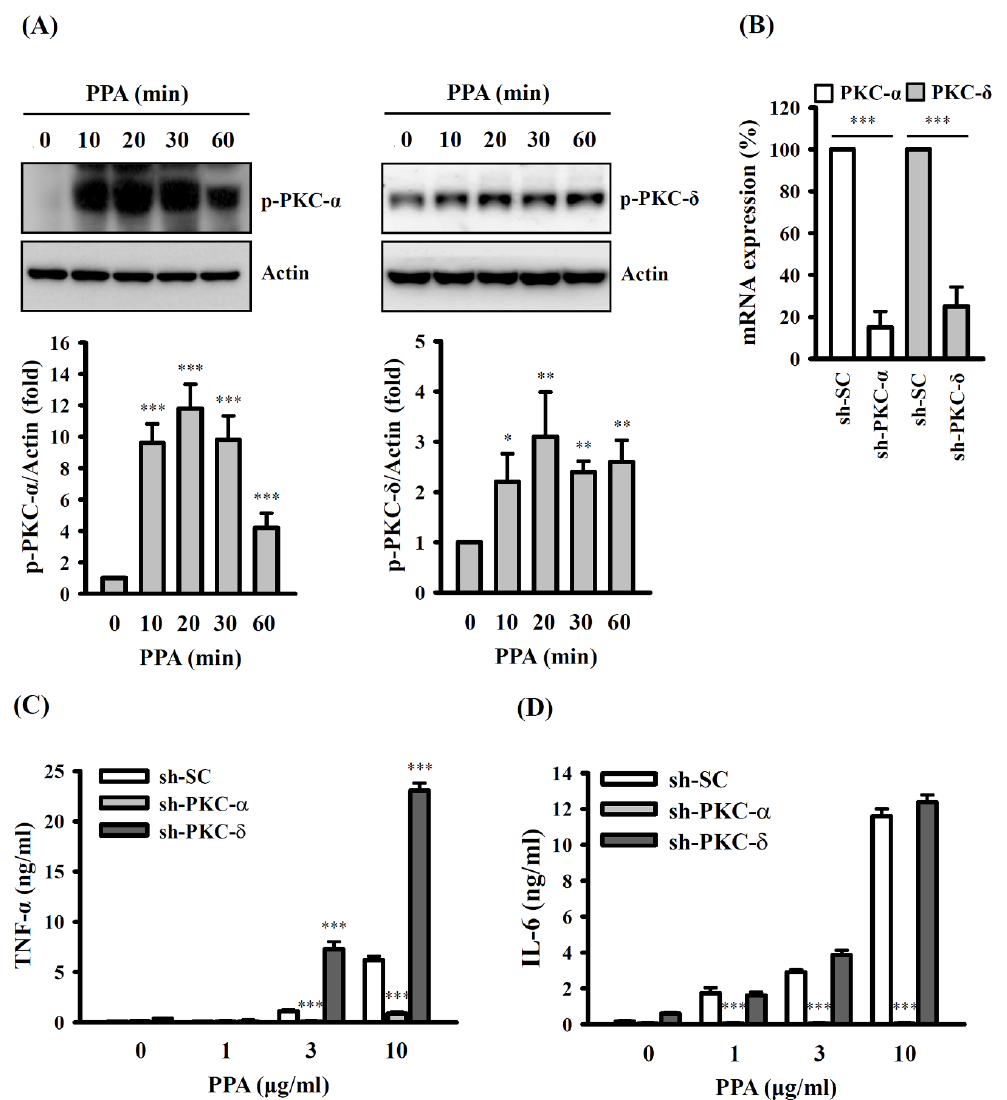
Figure 5. Effect of PKC- α / δ on PPA-mediated TNF- α and IL-6 expression in RAW264.7 macrophages. ( A ) The phosphory- lation levels of PKC- α and PKC- δ in PPA-stimulated cells. ( B ) The mRNA expression of sh-PKC- α , sh-PKC- δ and